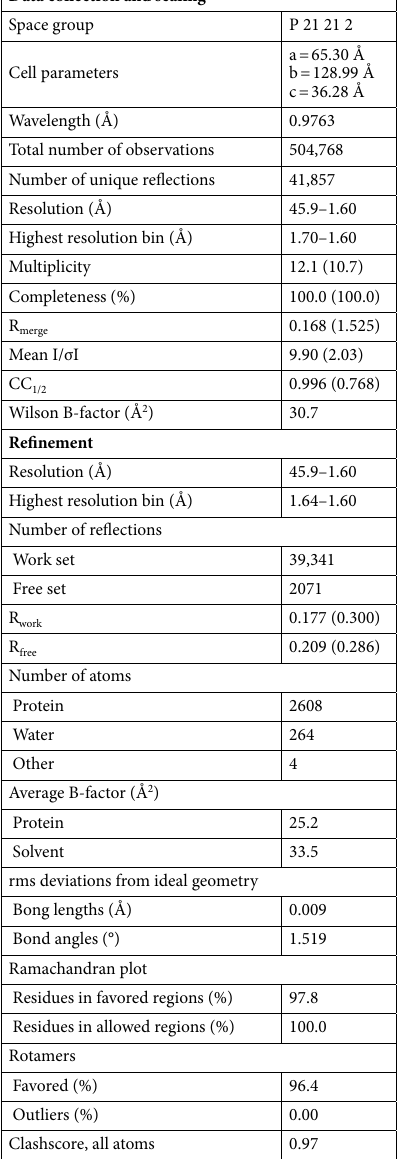
Table 2. Crystallographic data collection, scaling, refinement and model validation statistics. Values in parentheses are given for the highest resolution bin. The Ramachandran plot, rotamer and clashscore statistics are according to MolProbity 55